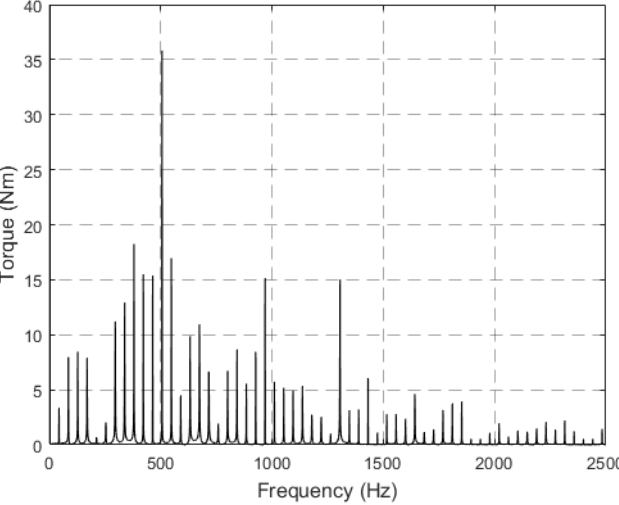
Figure 16. The torque amplitude frequency spectrum, basic DTC scheme, f ∈ (0, 2.5 kHz).